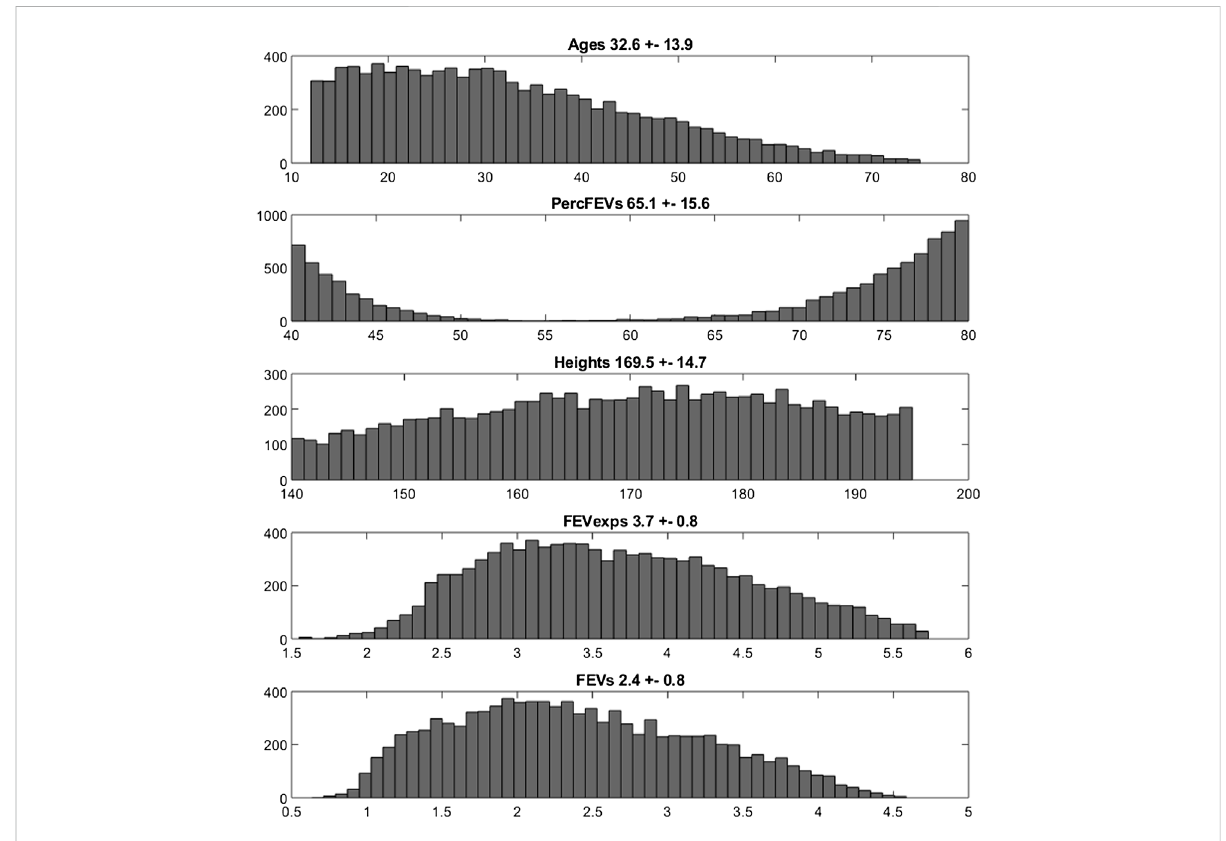
FIGURE 3 Histograms of frequencies of the simulated demographic and related-disease characteristics for the population undergoing 24 µg of formoterol via